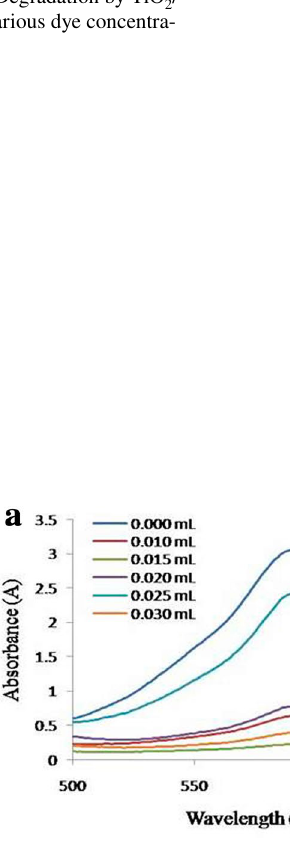
Fig. 6 a UV–Vis spectra of bromophenol blue dye by TiO 2 /GNP. b % Degradation of bromophenol blue by TiO 2 /GNP by various catalyst amounts Fig. 7 % Degradation by TiO 2 /